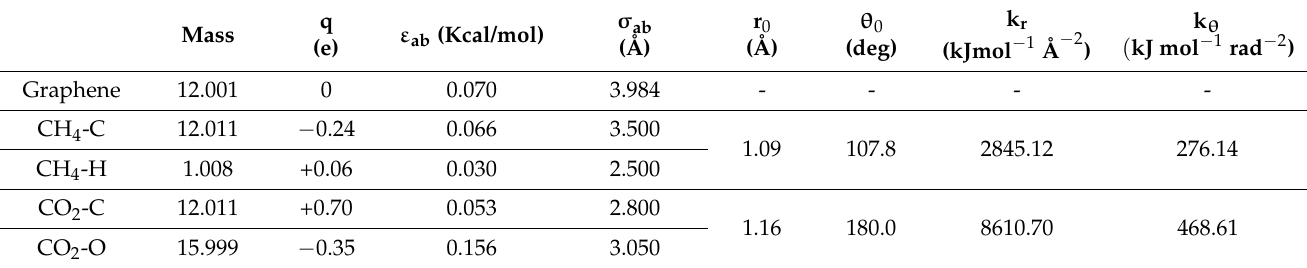
Table 1. Forcefield parameters for CO 2 , CH 4 , and graphene (q is the partial atomic charge; ε ab is the maximum LJ energy of attraction between a pair of atoms; σ ab is the collision diameter; r 0 is the equilibrium distance; θ 0 is the equilibrium angle; k r is a harmonic force parameter for bond lengths; and k θ a harmonic spring parameter for bond angles).